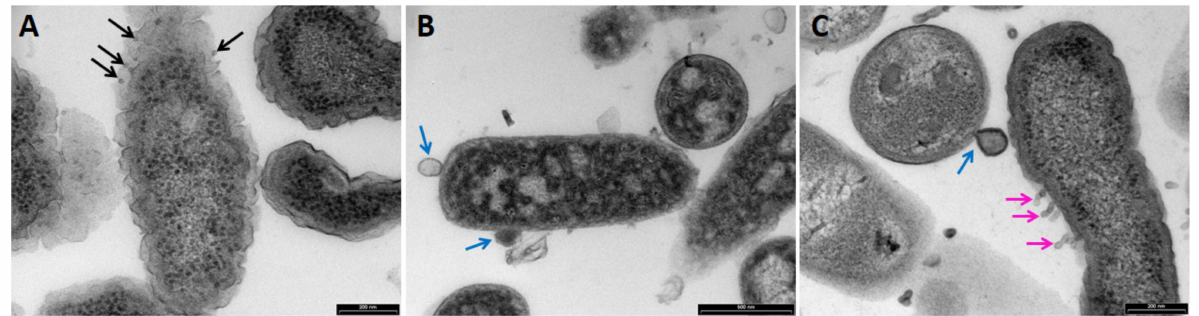
Figure 7. TEM images of Pseudomonas aeruginosa cells treated with ( A ) maltol at 4500 ppm, ( B ) DDAC at 500 ppm, and ( C ) blend of maltol and DDAC (95:5) at 5000 ppm. Black arrows: electron-condensed bodies aggregating near cell surface. Blue arrows: membrane bound segments extending from the cell membrane. Pink arrows: bleb-like vesicles burgeoning from the bacterial